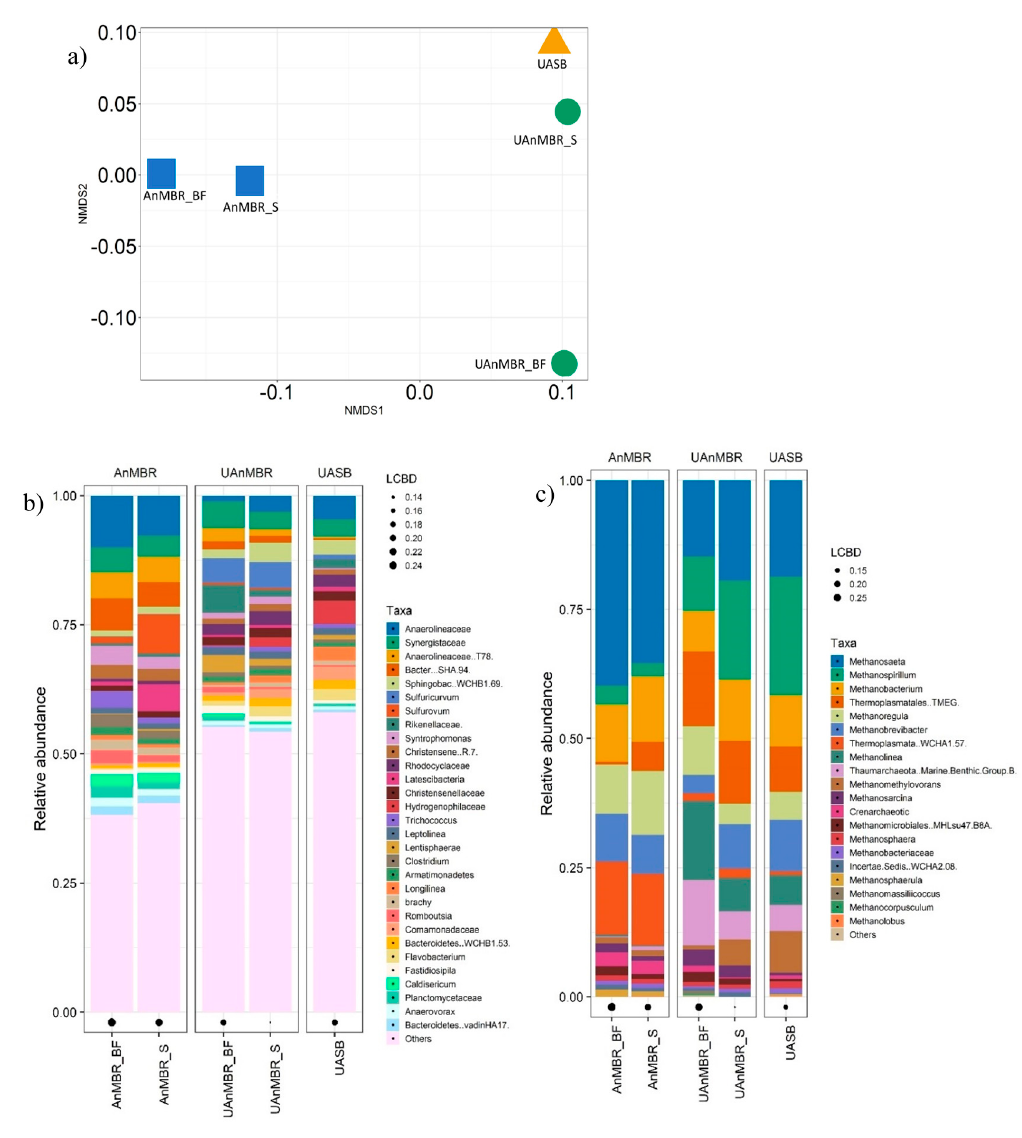
Figure 4. ( a ) Non ‐ metric multidimensional scaling (NMDS) plot of reactor communities, ( b )